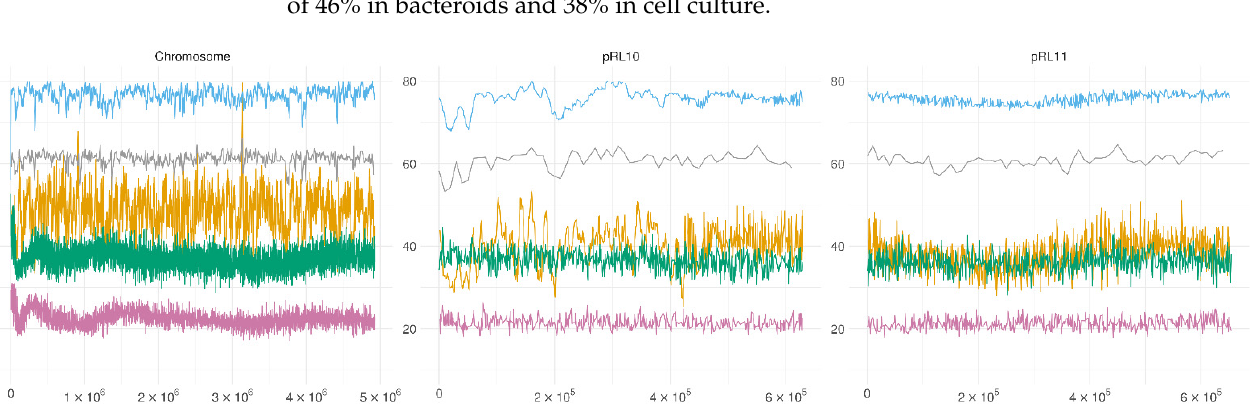
Figure 2. DNA methylation patterns. The plots represent the percentage of methylated adenine or cytosine in the R. legu- minosarum RCAM1026 genome shown across a 5 kb sliding window. The y scale shows the percentage of methylated reads mapped to the position. Blue—mA in bacteroids, purple—mA in cell culture, yellow—mC in bacteroids, green—mC in cell culture, grey—GC content. Figure 3. GGCGCC methylation across the replicons . Blue—GGCGCC motif methylation in bacteroids, purple—GGCGCC motif methylation in cell culture, yellow—methylation of cytosine in bacteroids, green—methylation of cytosine in bac- teroids, grey—GC content. Solid lines—polynomial regression lines calculated using ggplot_smooth “loess” method, for- mula “y~x”.